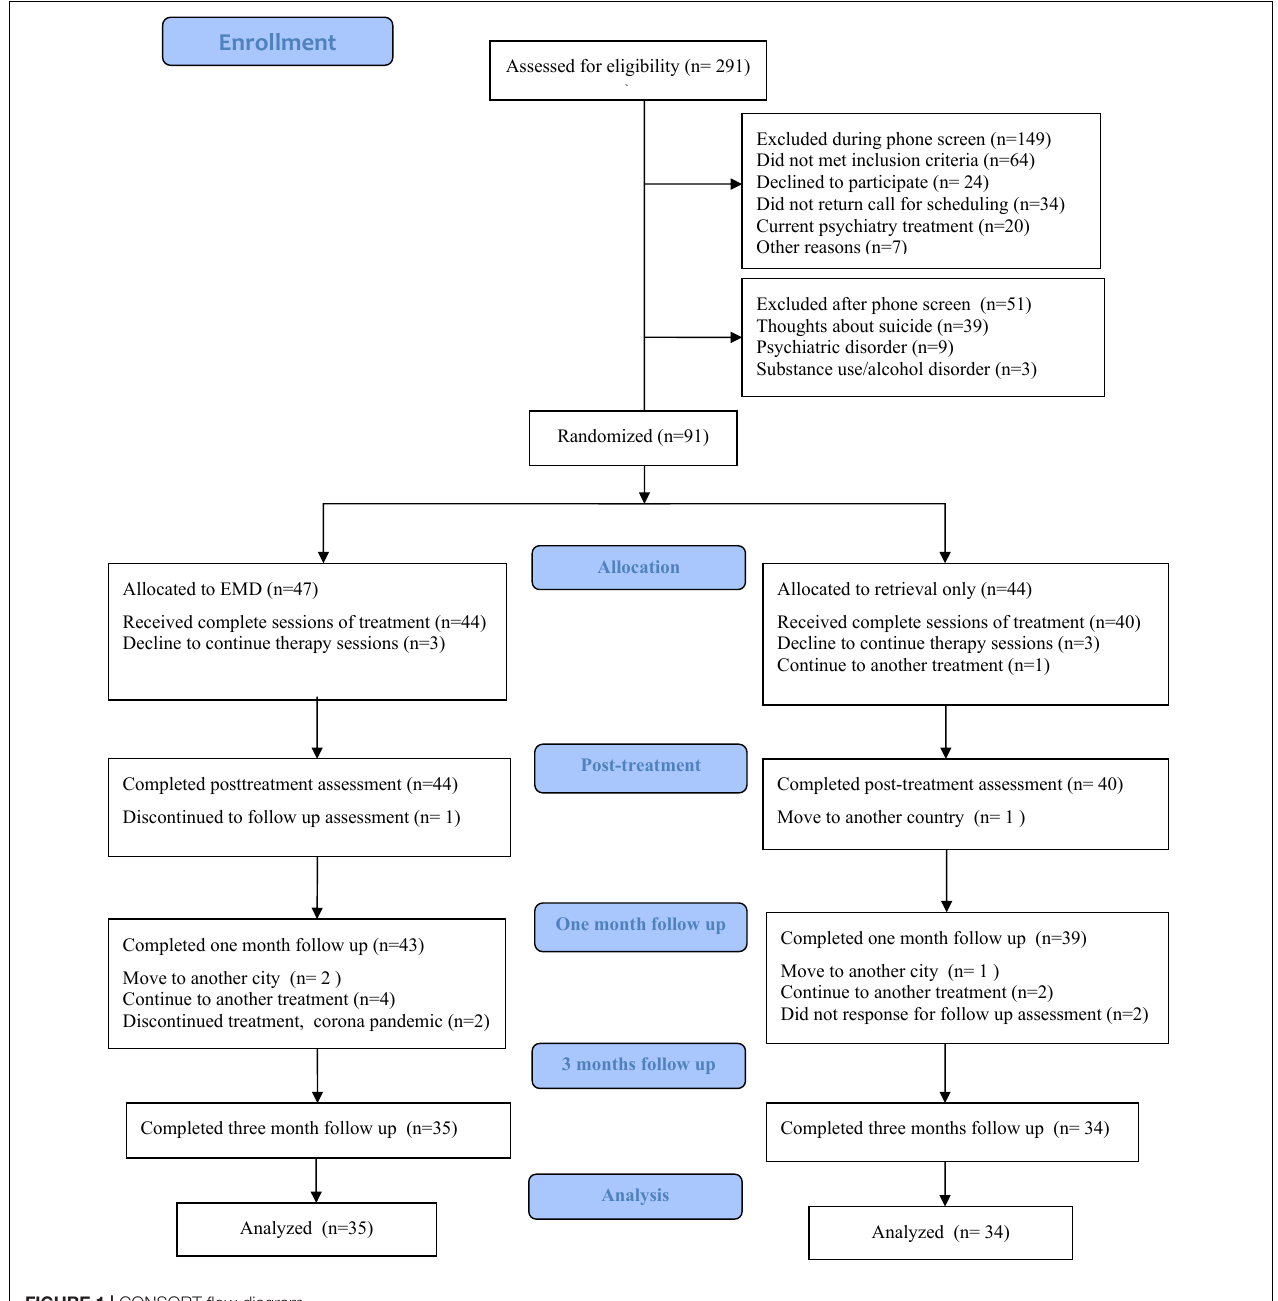
FIGURE 1 | CONSORT flow